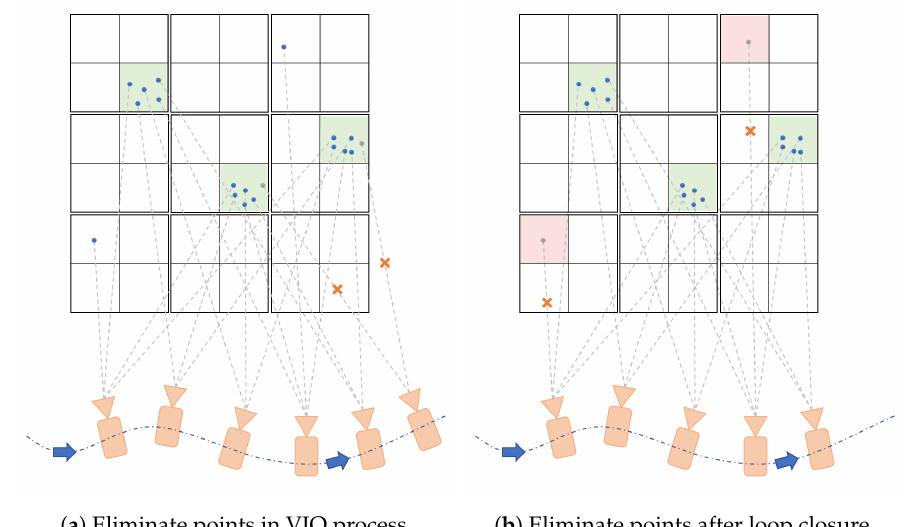
Figure 6. Points elimination. ( a ) illustrates the elimination during the VIO process. Cameras in figures represent keyframes. The points (blue) are continuously added to the octree leaf nodes until reaching the upper bound. Later coming points (gray) are rejected and also removed from point vector of corresponding keyframe to save space. After loop closure, as illustrated in ( b ), if a leaf node contains fewer points than a given threshold, the points are discarded, both in the octree and point vector of the